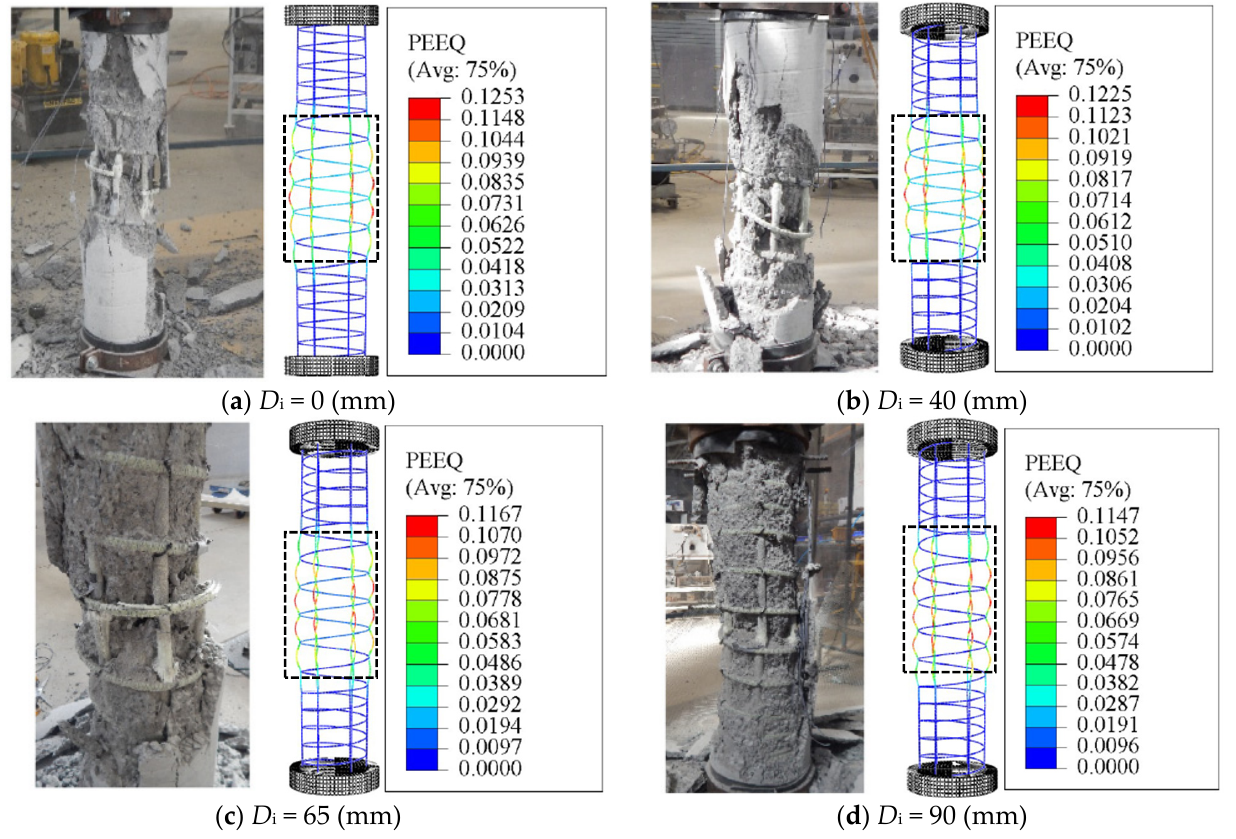
Figure 11. Experimental and finite element (FE) failure patterns of specimens: ( a ) C31.8-H100-6#5-00; ( b ) C31.8-H100-6#5-40; ( c ) C31.8-H100-6#5-65; ( d ) C31.8-H100-6#5-90: Considering the effect of different inner diameters. Note: PEEQ = Equivalent plastic strain.